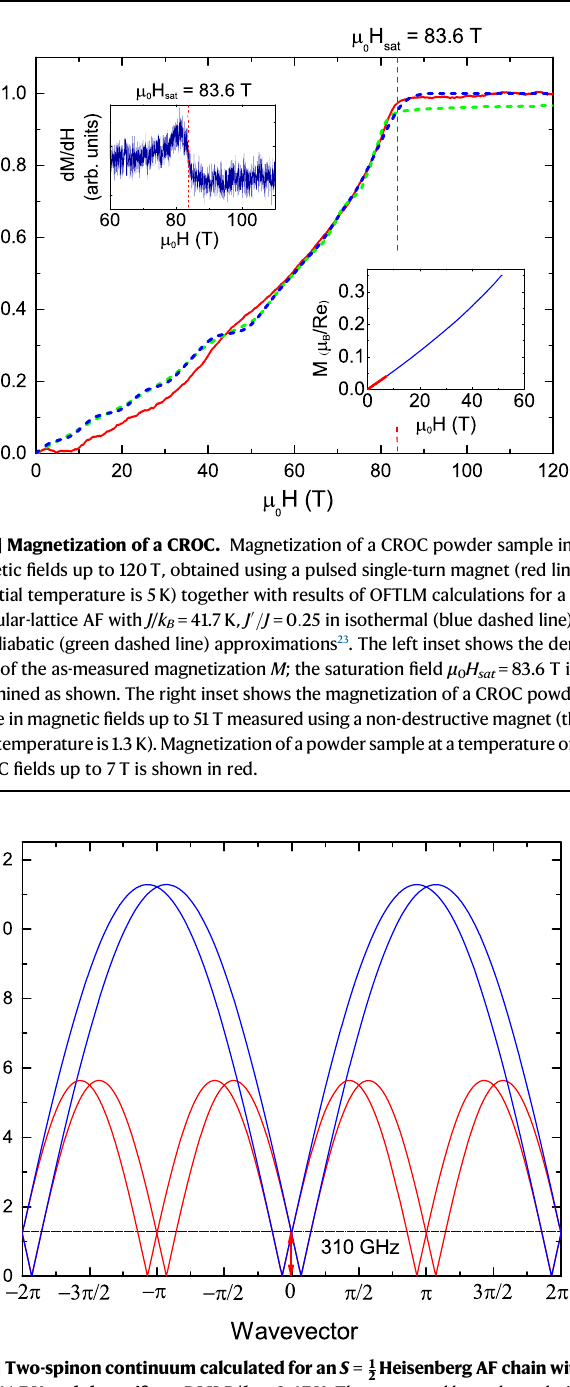
HeisenbergAFchainwith 2